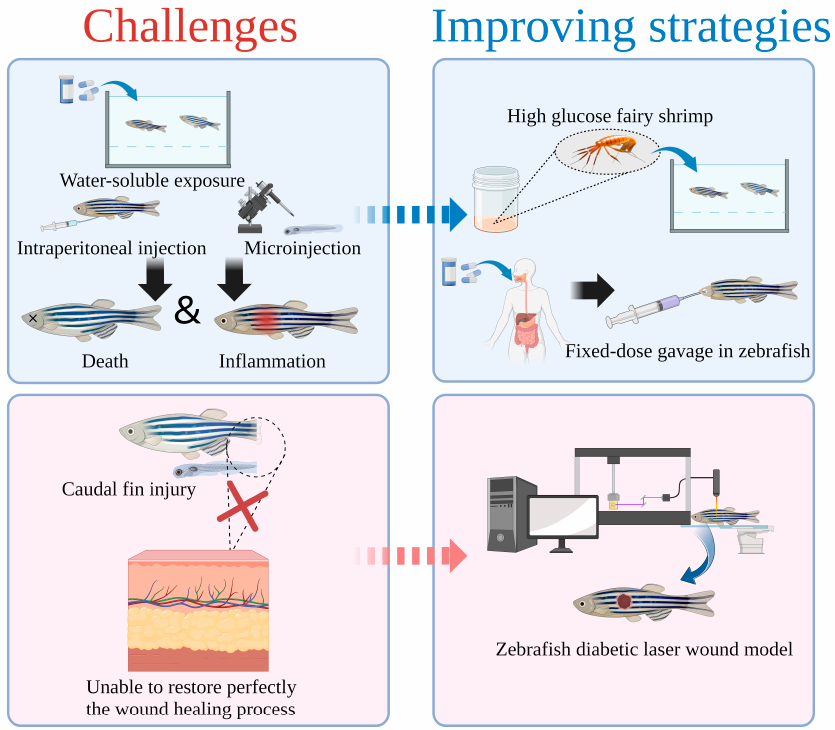
Figure 5. The challenge and improvement strategies of zebrafish as a model for diabetic wound healing.